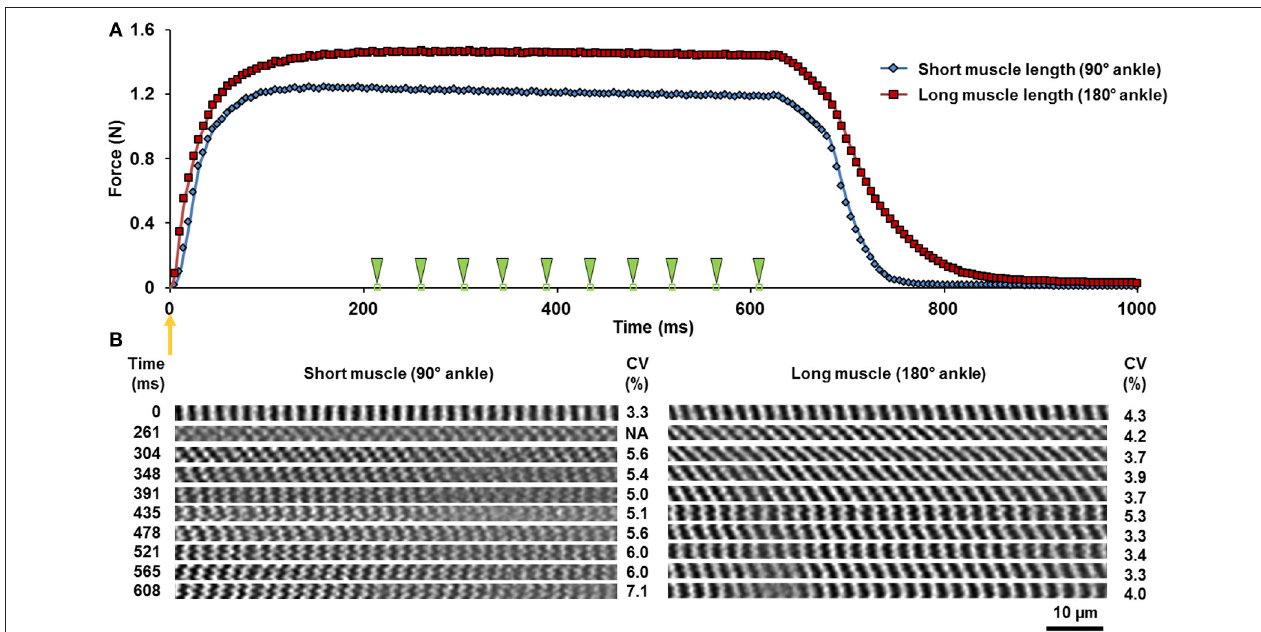
FIGURE 2 | (A) Force-time curve during a 600ms tetanic isometric contraction of the TA at the short (blue diamonds) and the long (red squares) lengths. The orange arrow indicates the time of muscle activation. The green arrowheads point to the times at which sarcomere images were acquired. (B) The corresponding time-series of the two-dimensional image bands of sarcomeres in the relaxed (0ms) and the activated state. The A-bands appear as white bands in the images. The coefficients of variation (CV) of sarcomere lengths are shown for each image band. Note that the image band acquired at time 215ms was excluded due to the image quality not meeting the selection criteria described in Methods In Vivo Imaging of Muscle under Relaxed and Activated